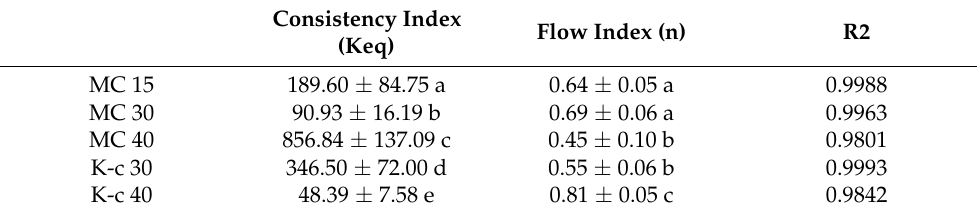
Table 4. Rheological characteristics of the different edible coating solutions fitted to the Power Law model.